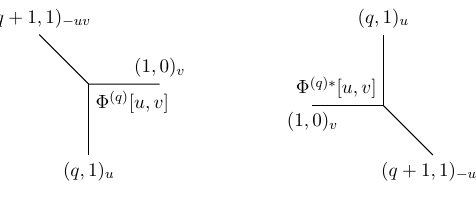
Figure 1 . (cid:8) ( q ) [ u; v ] and (cid:8) ( q ) (cid:3) [ u; v ].